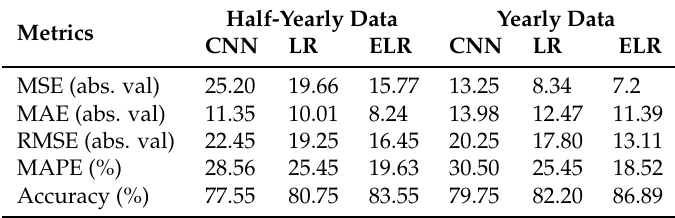
Table 20. Load performance metrics comparison for one week using the UCI